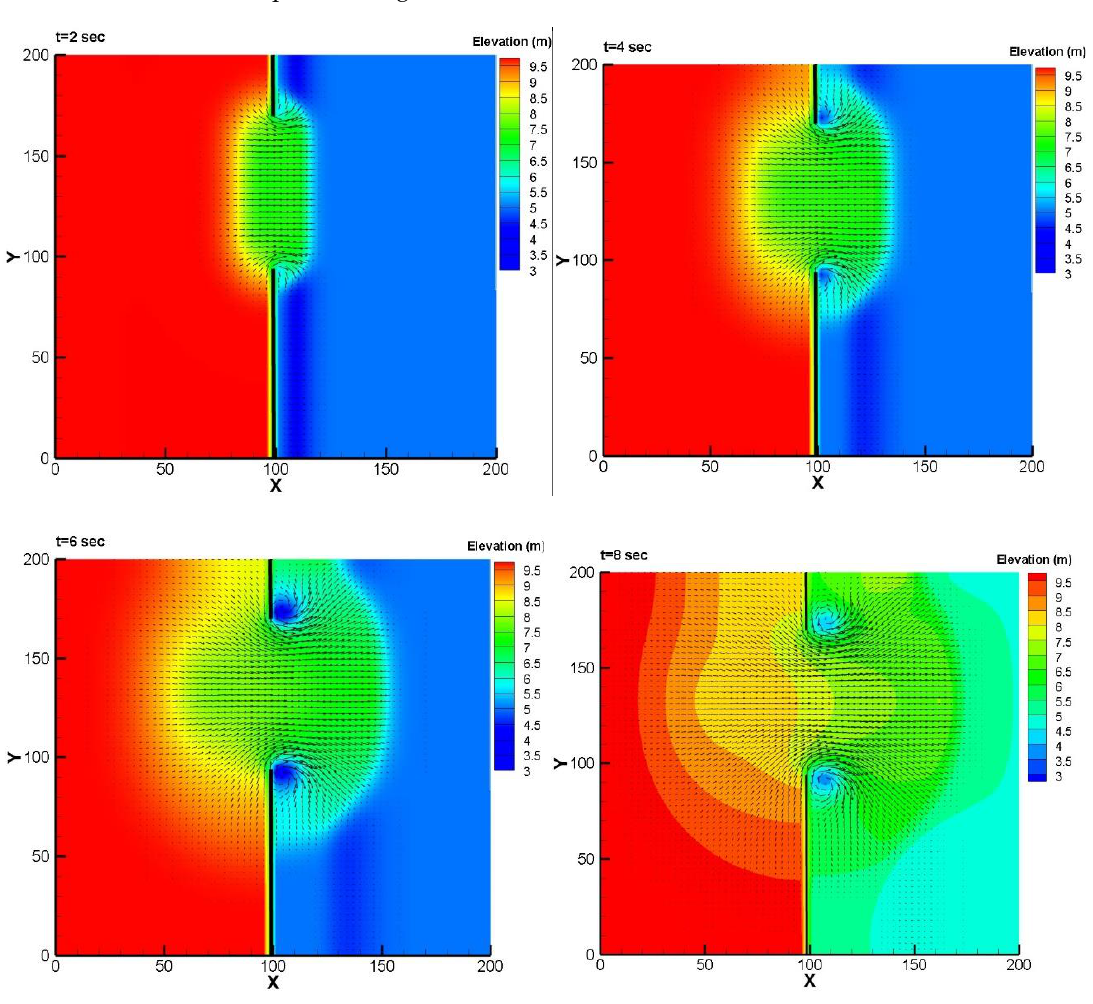
Figure 13. Temporal evolution of free surface elevations and velocity distribution. The flow separa- tions downstream of the broken dam are predicted.